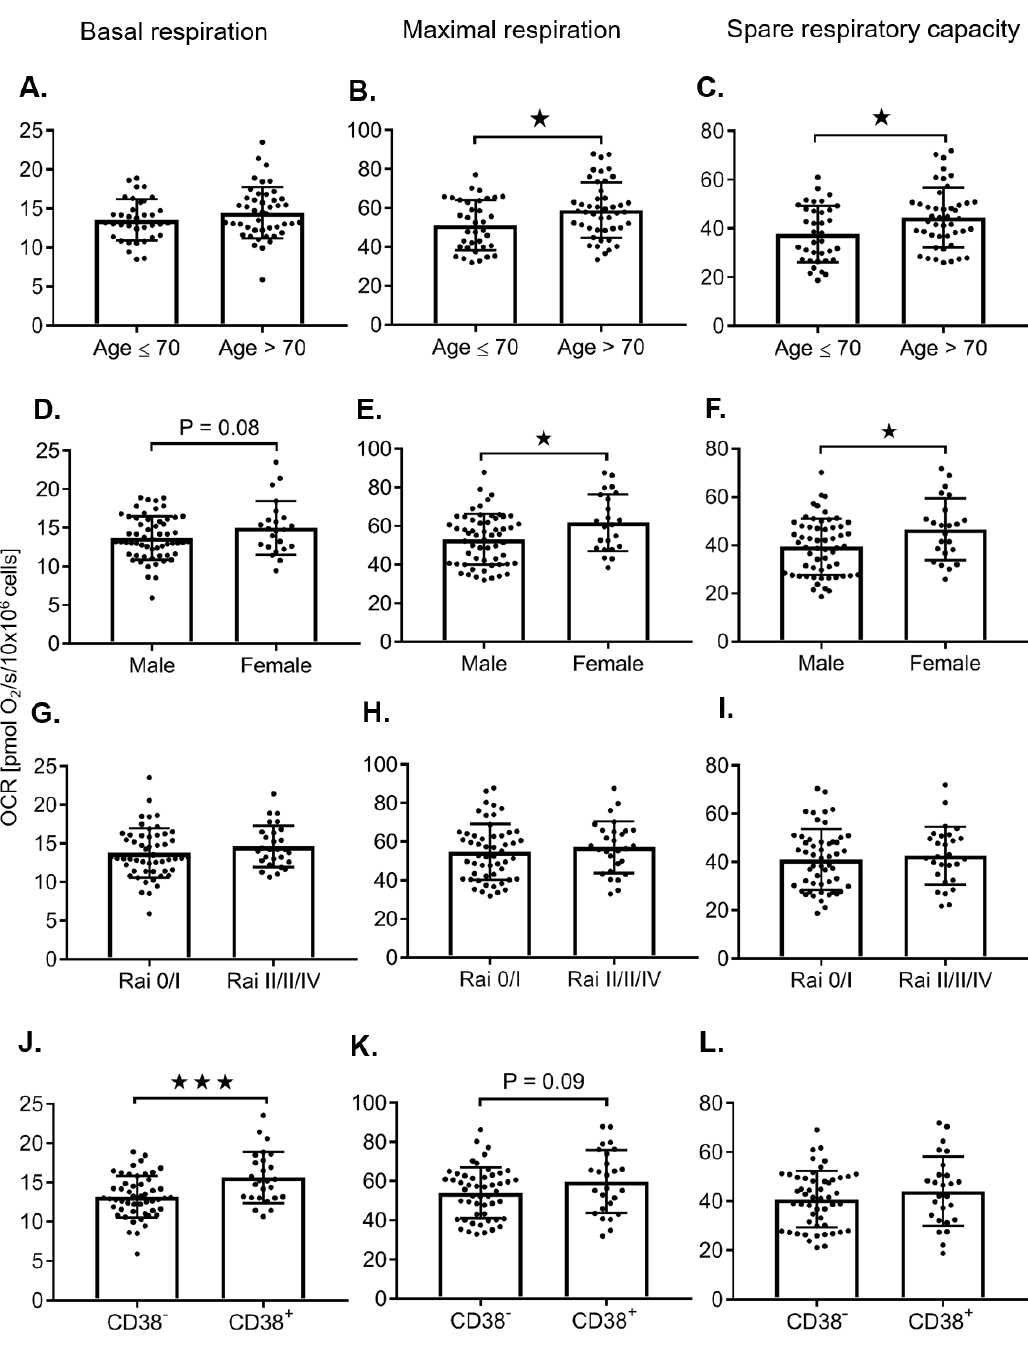
Figure 3. The influence of the clinical prognostic markers age, gender, Rai Stage, and cluster of differentiation 38 (CD38), on mitochondrial bioenergetic profiles in freshly isolated CLL cells. The correlation of clinical prognostic markers, age ( ≤ 70 vs. > 70; A – C ; N = 36/45), gender (male vs. female; D – F ; N = 58/23), Rai stage (0 and I vs. II, III, and IV; G – I ; N = 53/28), and CD38 (CD 38 - vs. CD 38 + J – L ; N = 51/26), with basal respiration, maximal respiration, and the spare respiratory capacity, respectively, are summarized in freshly isolated CLL cells (10 × 10 6 cells). Values are the mean ± S.D., * p < 0.05, ** p < 0.01, and *** p < 0.0005 (unpaired two-tailed Student’s t- test).